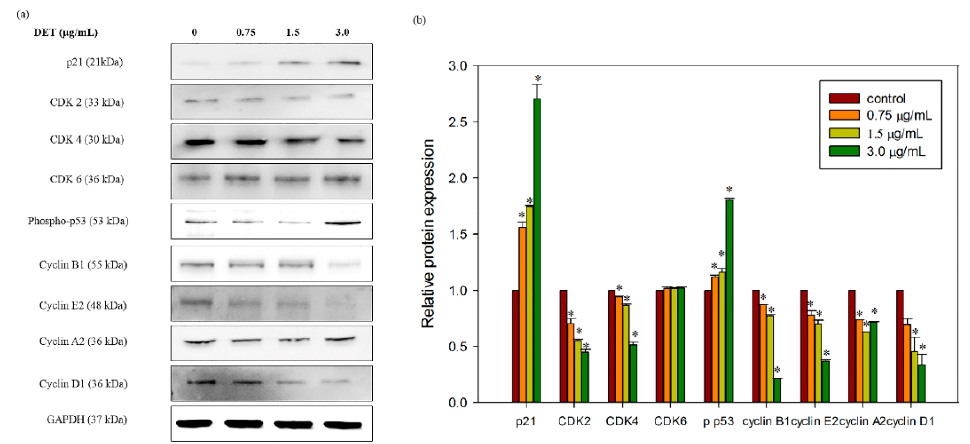
Figure 7. Effect of DET on cell cycle-related protein expressions in HCT116 cells. HCT116 cells were treated with different concentrations of DET (0.75, 1.5 and 3.0 µg/mL) at 24 h. ( a ) Representative image of p21, phospho-p53, CDK2, CDK4, CDK6, cyclin B1, cyclin E2, Cyclin A2 and Cyclin D1 expression level with their respective western blot band intensity; ( b ) The bar chart showed the relative protein expression levels. The data expressed as mean ± S.E. from three individual experiments. Asterisks indicate significantly different value from control (* p < 0.001).